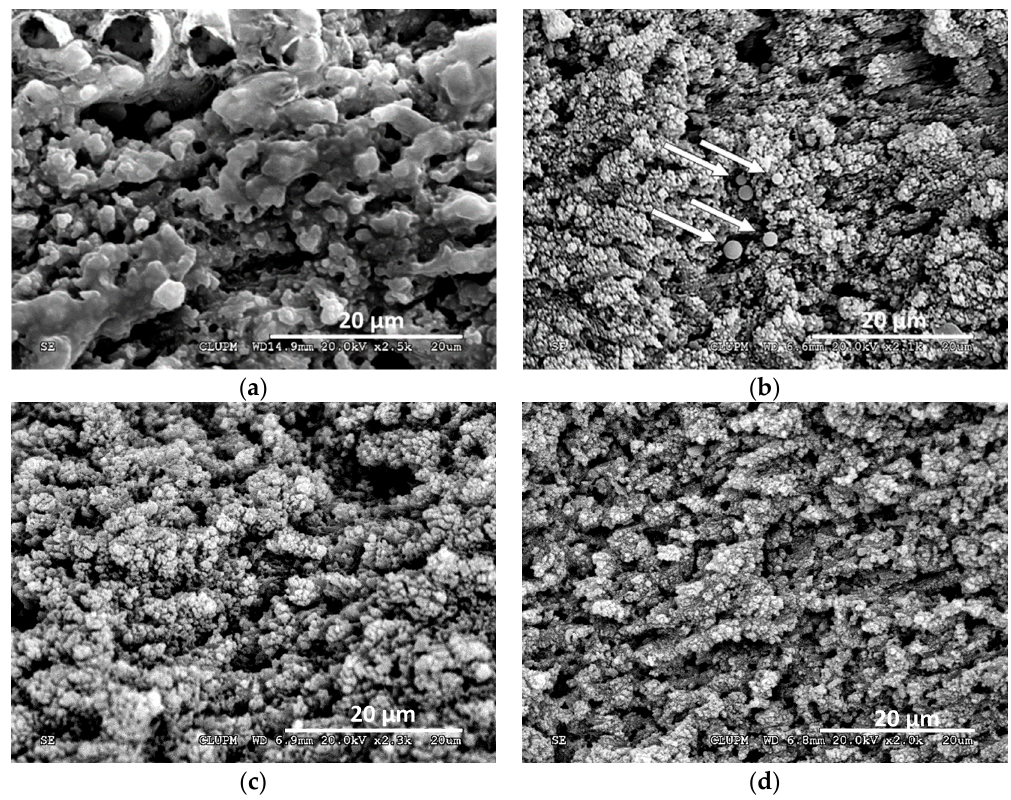
Figure 5. Different SEM images of bone samples ablated using the IR ps laser source. Thermal damage in the form of rounded shapes is clearly visible in images ( a ) and ( b ). The pulse fluence, process speed, repetition frequency, pitch, and number of cycles used for each sample are, respectively: ( a ) 13.9 J/cm 2 , 5000 mm/s, 400 kHz, 20 µm, 20; ( b ) 13.9 J/cm 2 , 500 mm/s, 100 kHz, 20 µm, 20; ( c ) 9.9 J/cm 2 , 500 mm/s, 100 kHz, 20 µm, 20; ( d ) 8.4 J/cm 2 , 500 mm/s, 100 kHz, 20 µm, 20.